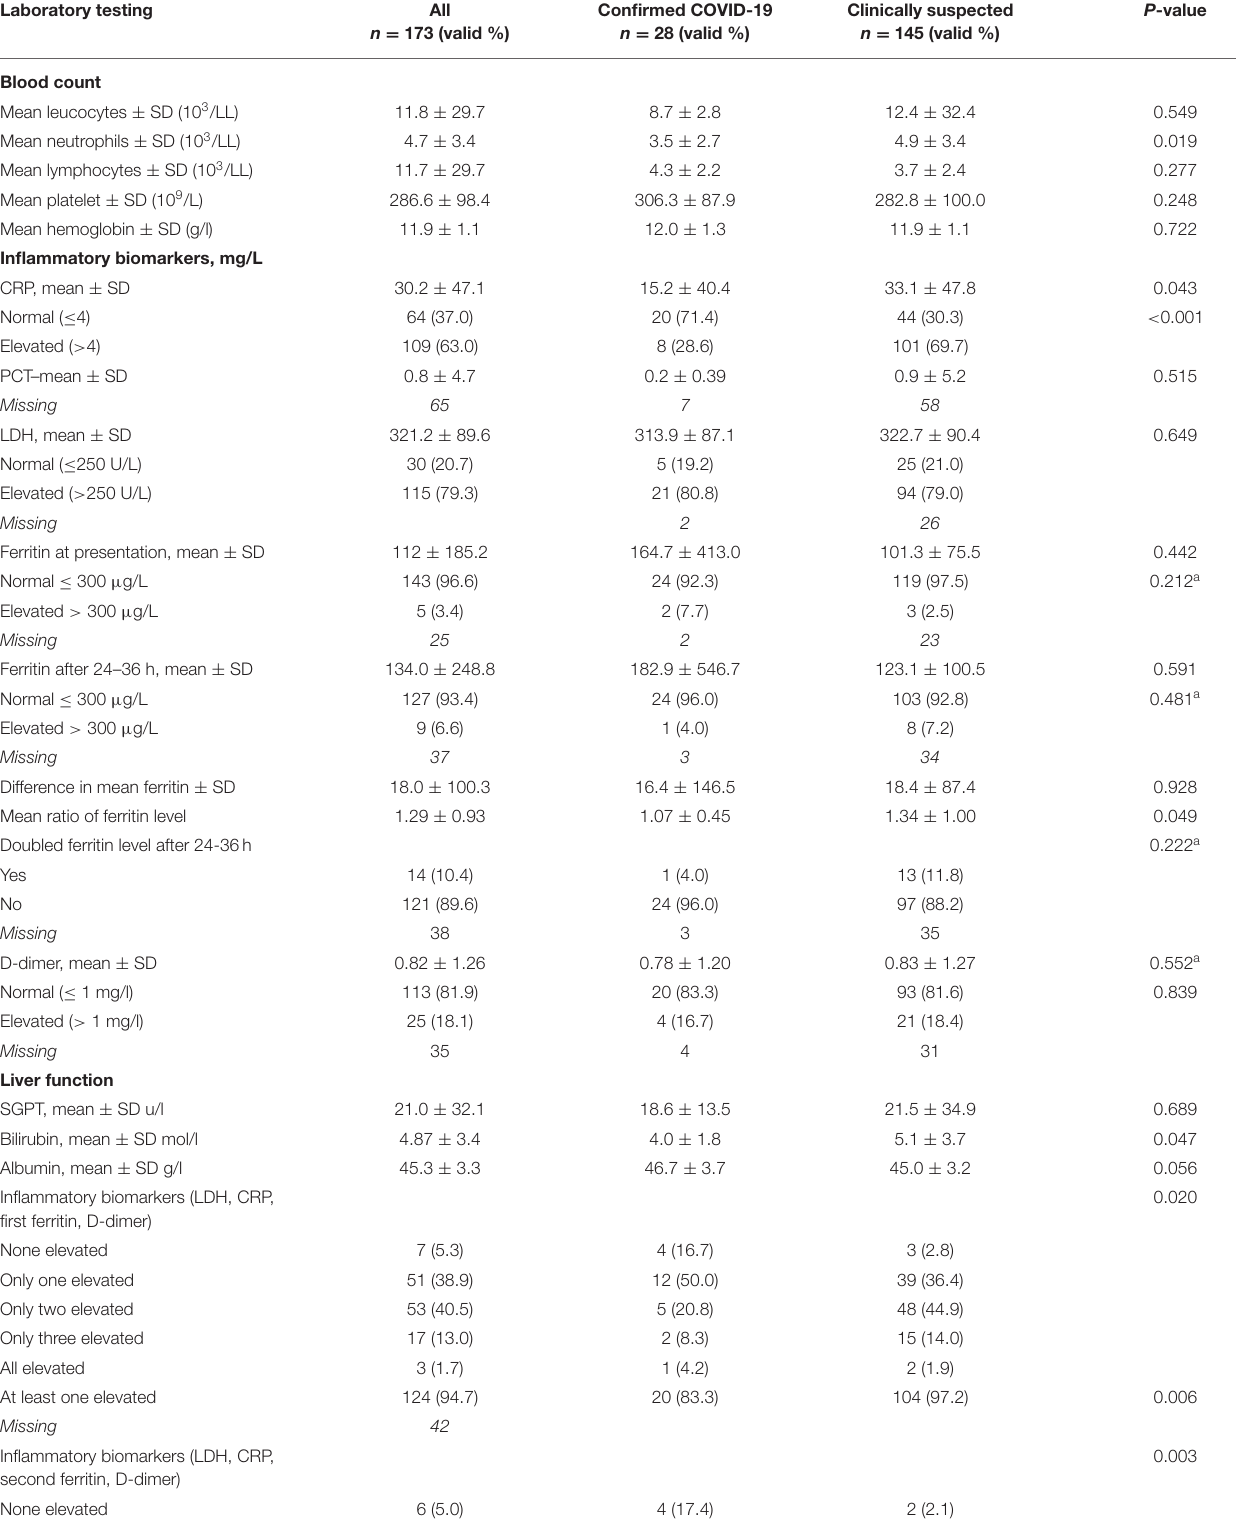
TABLE 2 | Distribution of confirmed (RT-PCR-positive) and clinically suspected (RT-PCR-negative) pediatric patients according to their laboratory findings. Laboratory testing All Confirmed COVID-19 n = 173 (valid %) n = 28 (valid